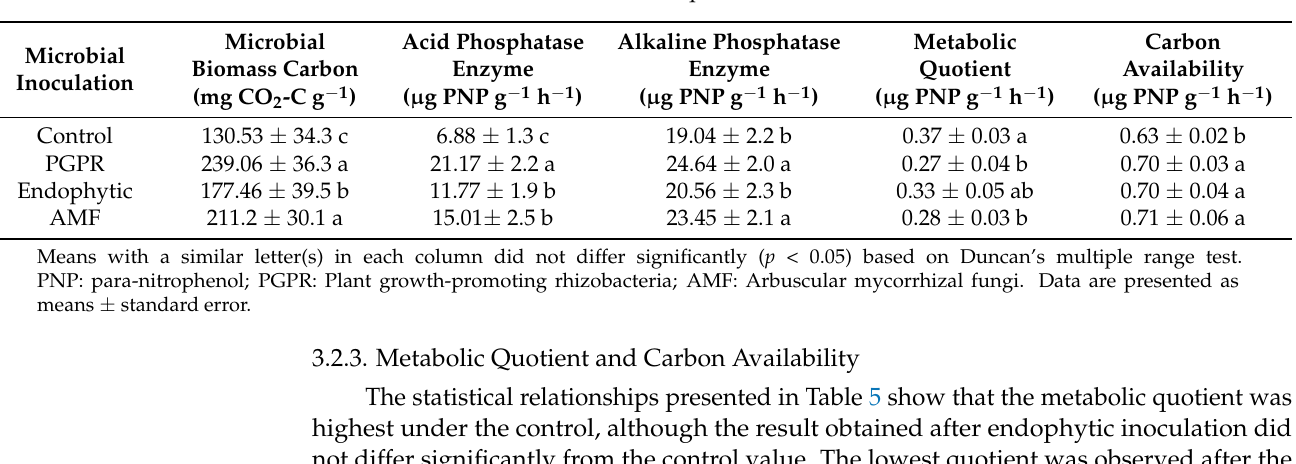
Table 5. The effect of microbial inoculation on qualitative indices of the soil